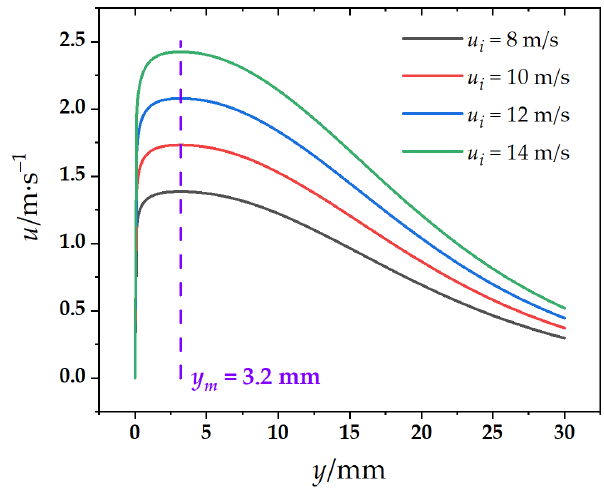
Figure 8. Velocity profile of mildly curved surface.